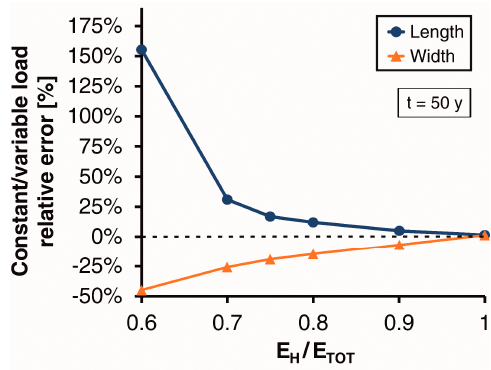
Figure 12. Relative error on plume dimensions of constant thermal load simulations compared to variable load simulations, with different values of the ratio of heating over total demand E H / E TOT ; isotherm ∆ T = 1 °C.